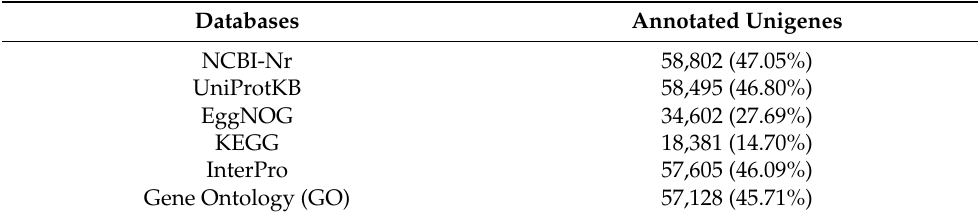
Table 2. A minutum unigenes annotation results against different